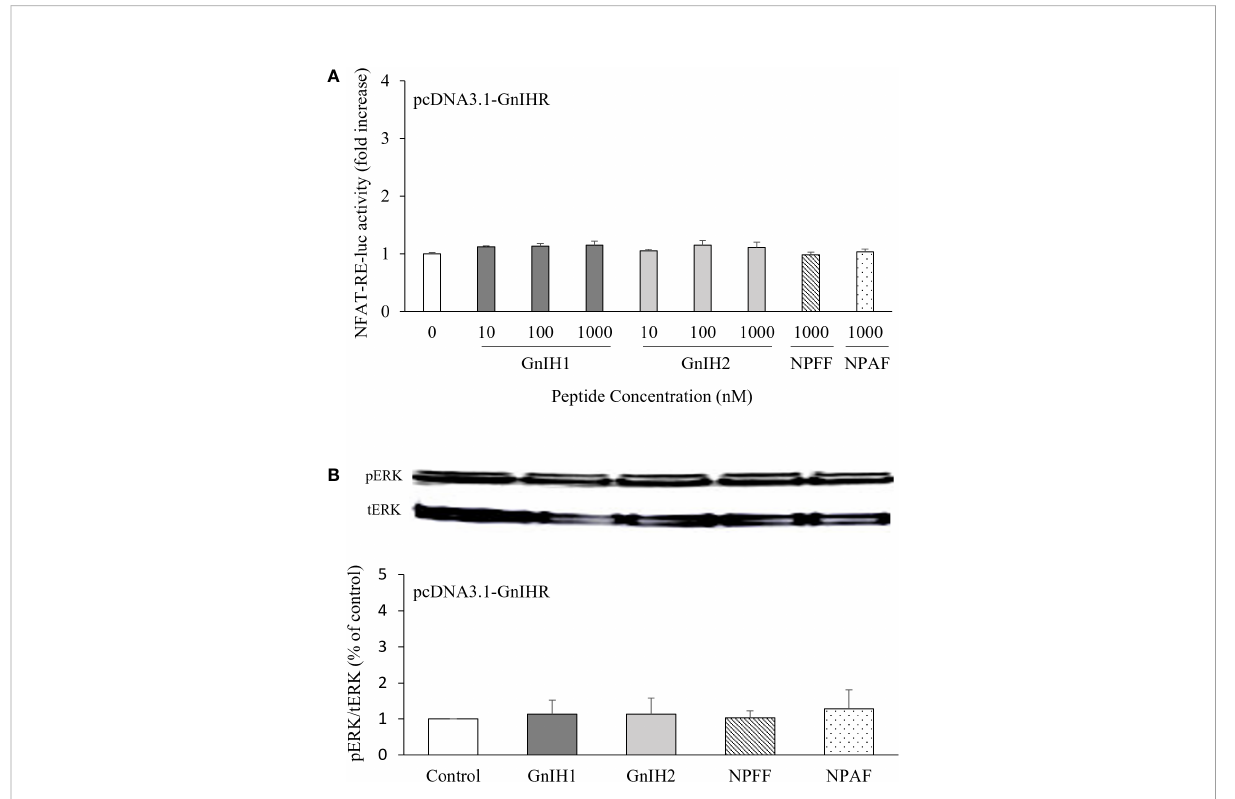
FIGURE 4 Effects of GnIH and NPFF peptides on NFAT-RE-luc activity (A) and ERK phosphorylation levels (B) in COS-7 cells transfected with sea bass GnIHR. (A) Cells were challenged with GnIH and NPFF peptides for 6 h and then harvested for assays. (B) Cells were challenged with 1 m M GnIH and NPFF peptides for 10 min and then harvested for Western blot analysis. Data are presented as the mean ± SEM